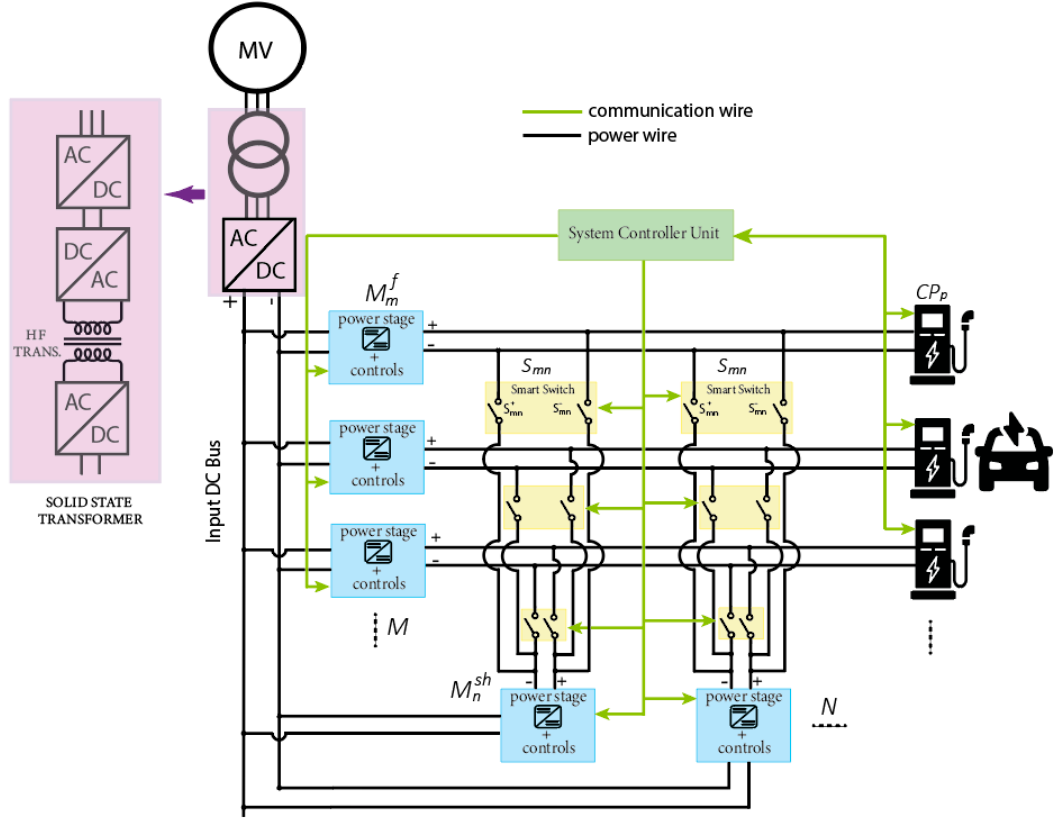
Figure 3. Block diagram of the proposed modular UFCS.